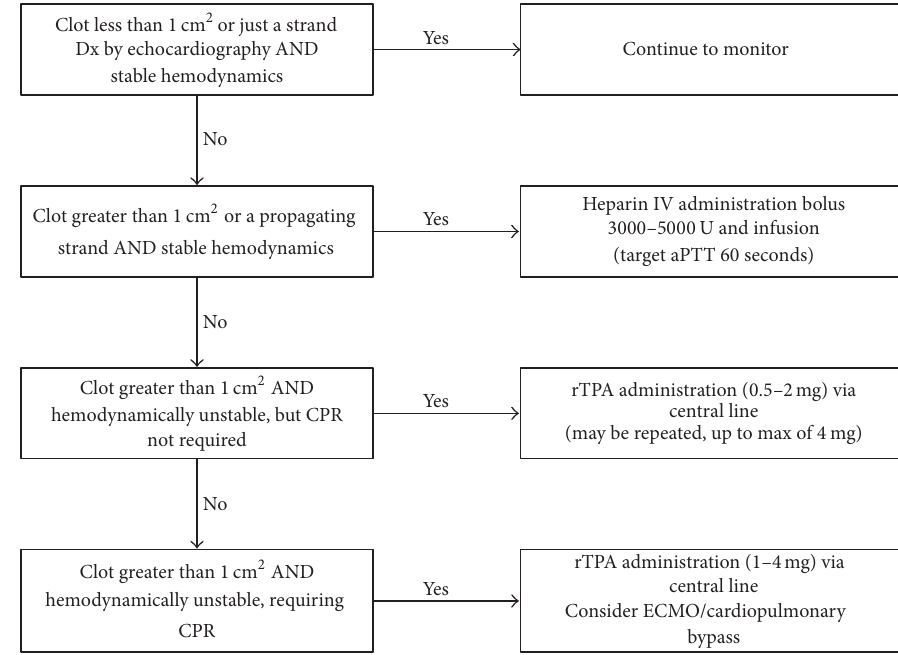
Figure 6: Management of an intraoperative intracardiac clotting